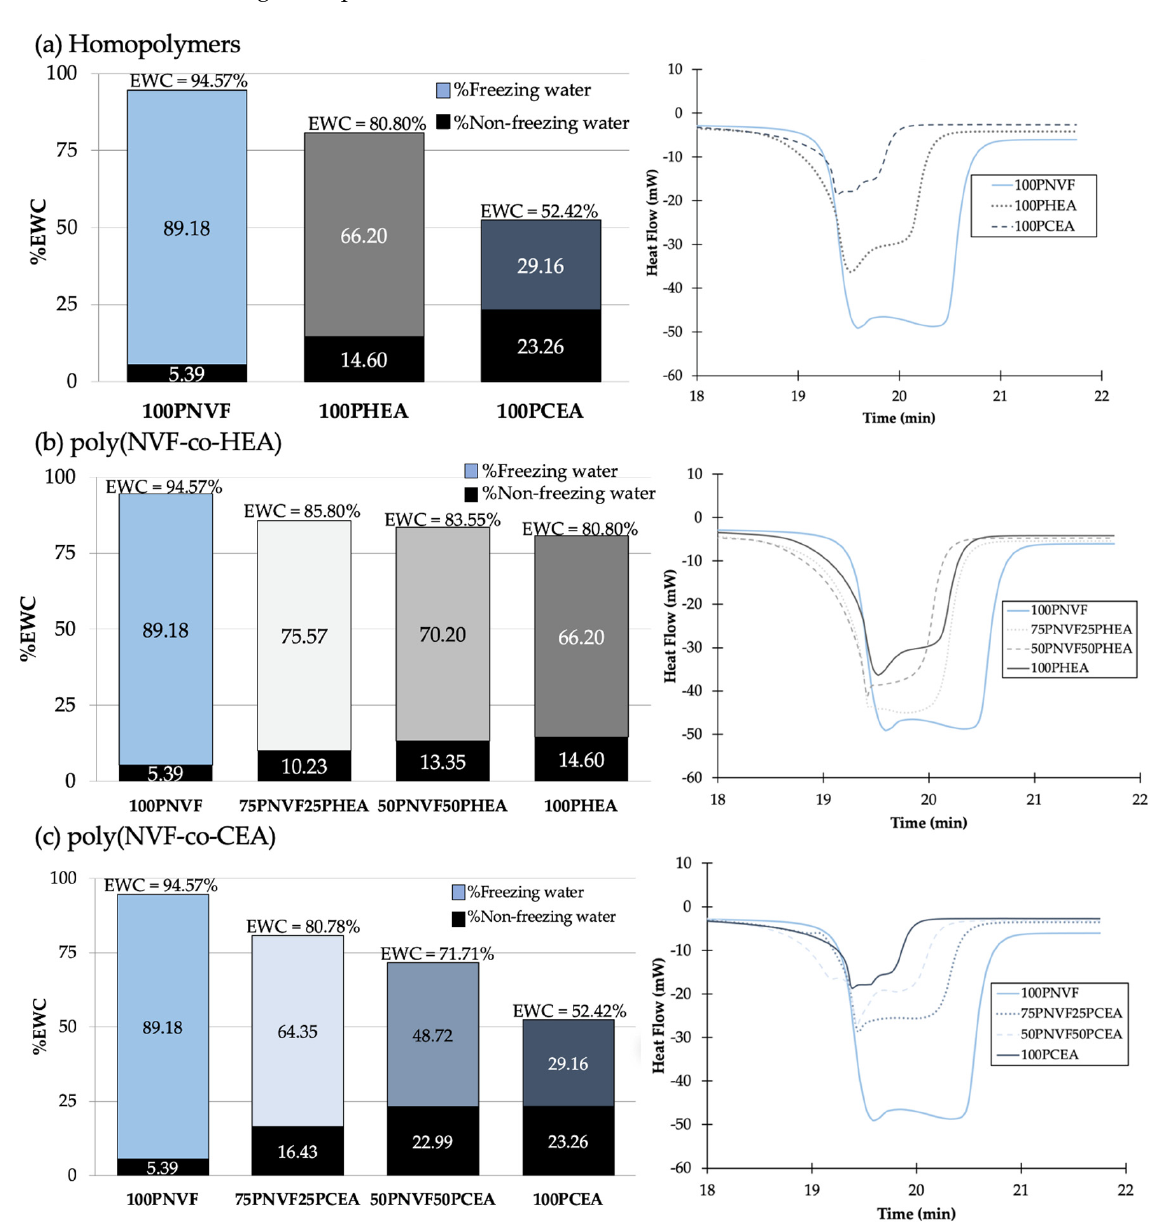
Figure 2. %EWC ( left ) and DSC endotherms ( right ) of ( a ) homopolymers, ( b ) P(NVF − co − HEA) hydrogels, and ( c ) P(NVF − co − CEA) hydrogels.